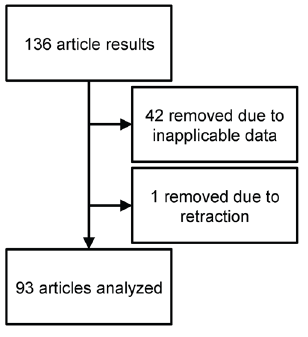
Figure 1. Flowchart of study selection.